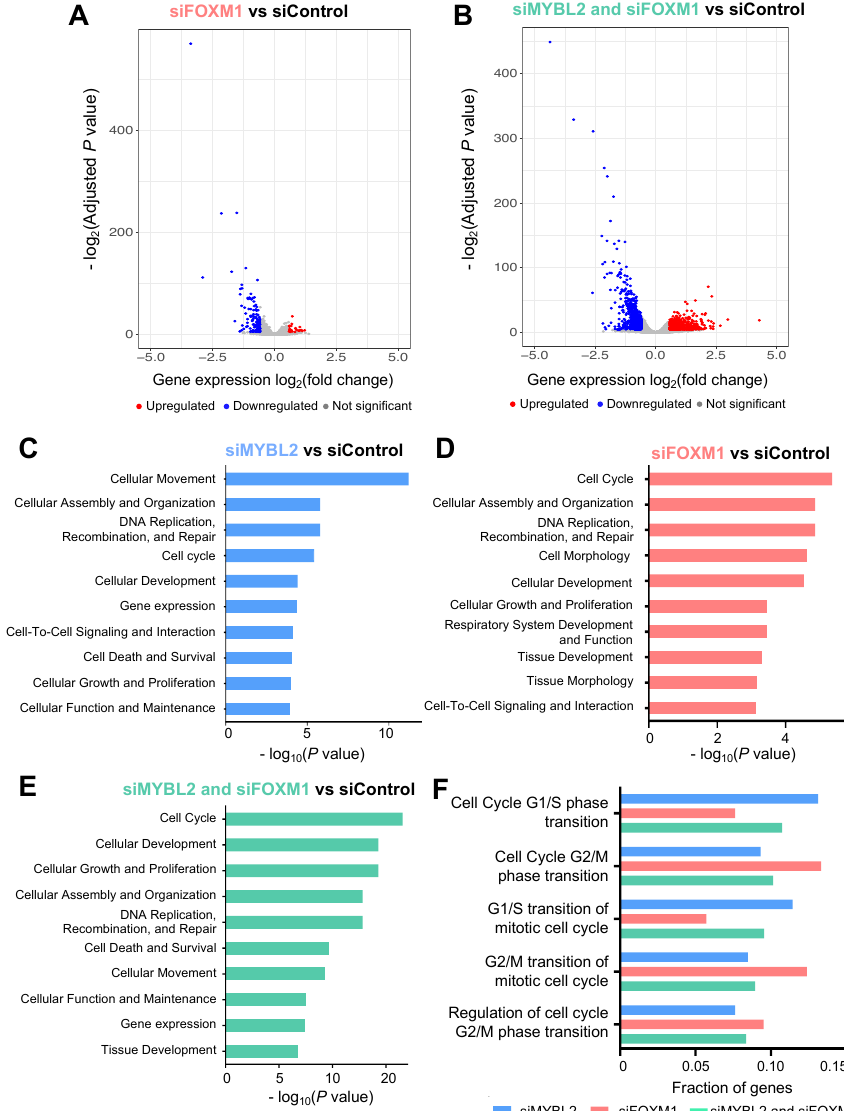
Figure 3. FOXM1 activates cell cycle-related genes together with MYBL2 in lung adenocarcinoma cells. ( A ) A volcano plot demonstrating differential gene expression after knockdown of FOXM1 in A549 cells. X -axis shows the log2 fold change between FOXM1 siRNA (siFOXM1) and control scrambled siRNA (siControl) cells, and Y -axis shows the − log2(adjusted p -value) upon the compari- son between siFOXM1 and siControl. The red dots represent the upregulated genes, the blue dots represent the downregulated genes, and the gray dots represent the genes that are not statistically significantly differentially expressed ( − log2(adjusted p -value) > 0.05 and fold change < 1.5). ( B ) A volcano plot demonstrating differential gene expression after knockdown of both MYBL2 and FOXM1 (siMYBL2 and siFOXM1) in A549 cells. X -axis shows the log2 fold change between siMYBL2 and siFOXM1 and siControl cells, and Y -axis shows the − log2(adjusted p -value) upon the comparison between siMYBL2 and siFOXM1 and siControl. The red dots represent the upregulated genes, the blue dots represent the downregulated genes, and the gray dots represent the genes that are not statistically significantly differentially expressed ( − log2(adjusted p -value) > 0.05 and fold change < 1.5). ( C – E ) Barplots showing the top 10 biological functional categories, in which genes changed by siMYBL2, siFOXM1, and siMYBL2 and siFOXM1 are most enriched. ( F ) Fraction of genes whose expression levels are changed upon siMYBL2, siFOXM1, and siMYBL2 and siFOXM1 and involved in each cell cycle phase are